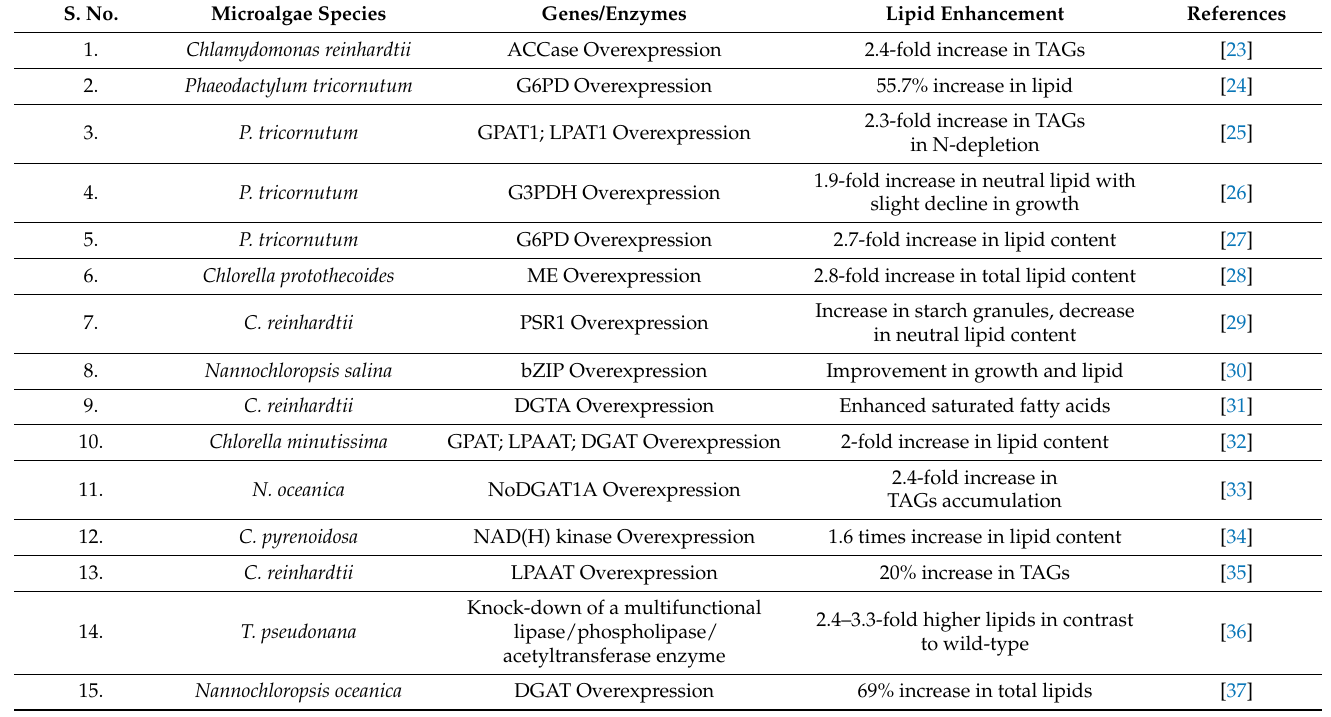
Table 1. Overexpression of genes/enzymes resulted in lipid enhancement in microalgae